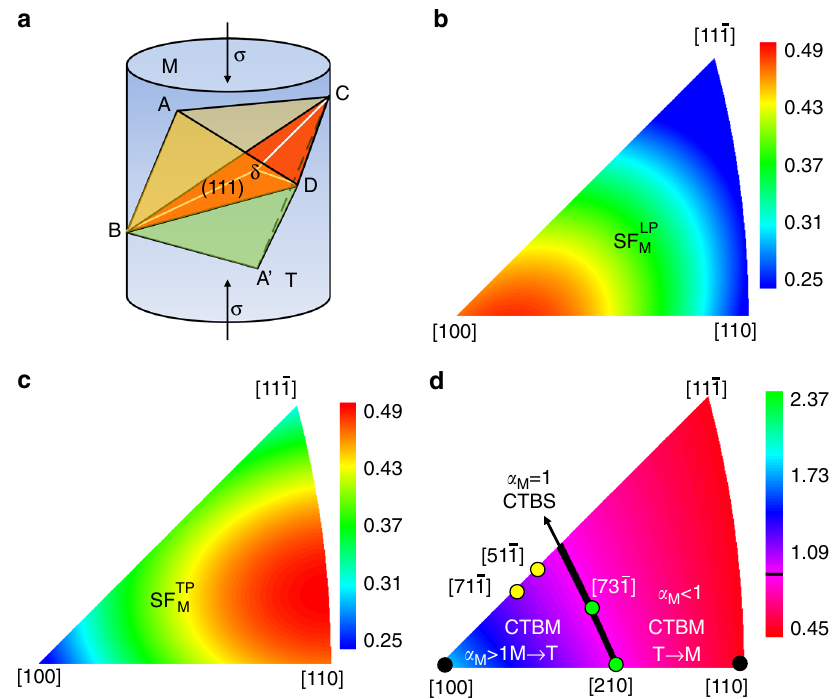
Fig. 1 Coherent twin boundary sliding vs. coherent twin boundary migration. a Schematic illustration showing double Thompson tetrahedra (tetrahedron of matrix and twin) in a Cu pillar containing (111) twin planes. Color contours showing calculated values of Schmid factor of the b leading partial dislocation and c trailing partial dislocation for all the loading orientations in the ½ 100 (cid:2) (cid:3) ½ 110 (cid:2) (cid:3) ½ 111 (cid:2) stereographic triangle. d The standard triangle of the stereographic projection showing different regimes for coherent twin boundary sliding (CTBS) and coherent twin boundary migration